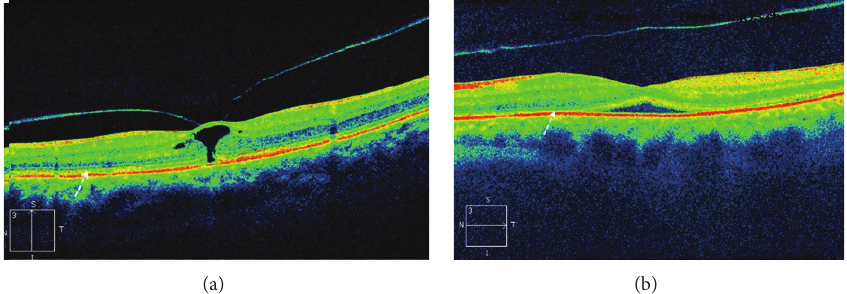
Figure 3: (a) Focal VMT. The arrow points to the ellipsoid zone. (b) Release of VMT after injection of ocriplasmin. A severe disruption in the ellipsoid zone is shown (by courtesy of Dr. Peter K. Kaiser, Cleveland Clinic, Cleveland, OH, USA).